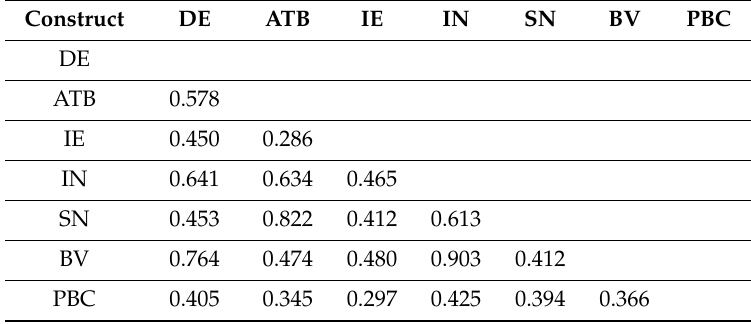
Table A4. Discriminant validity: heterotrait–monotrait ratio (HTMT). Construct